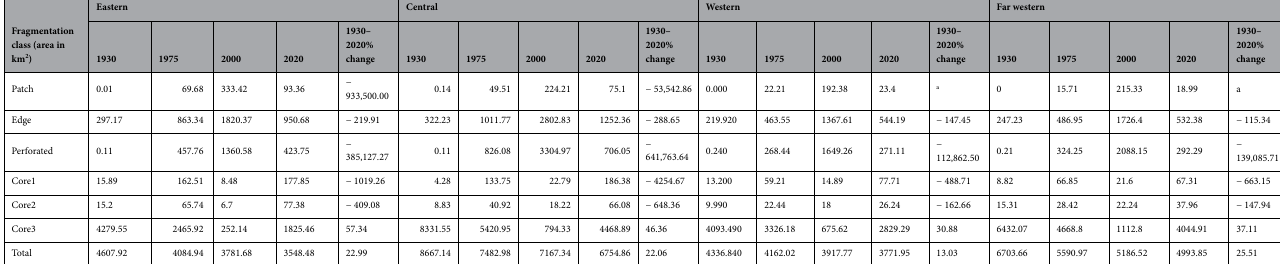
Table 4. Region wise forest fragmentation in Nepal. Change percentage represented by ‘a’ means the highly inflated figure due to very small denominator. a The estimate is not reliable as forest cover within these categories were very small in